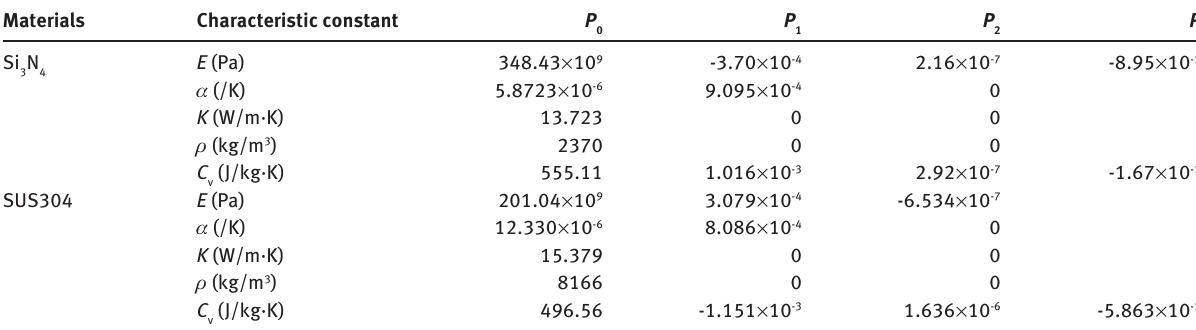
Table 2 Parameters of the FGM hollow cylinder relative to temperature. Materials